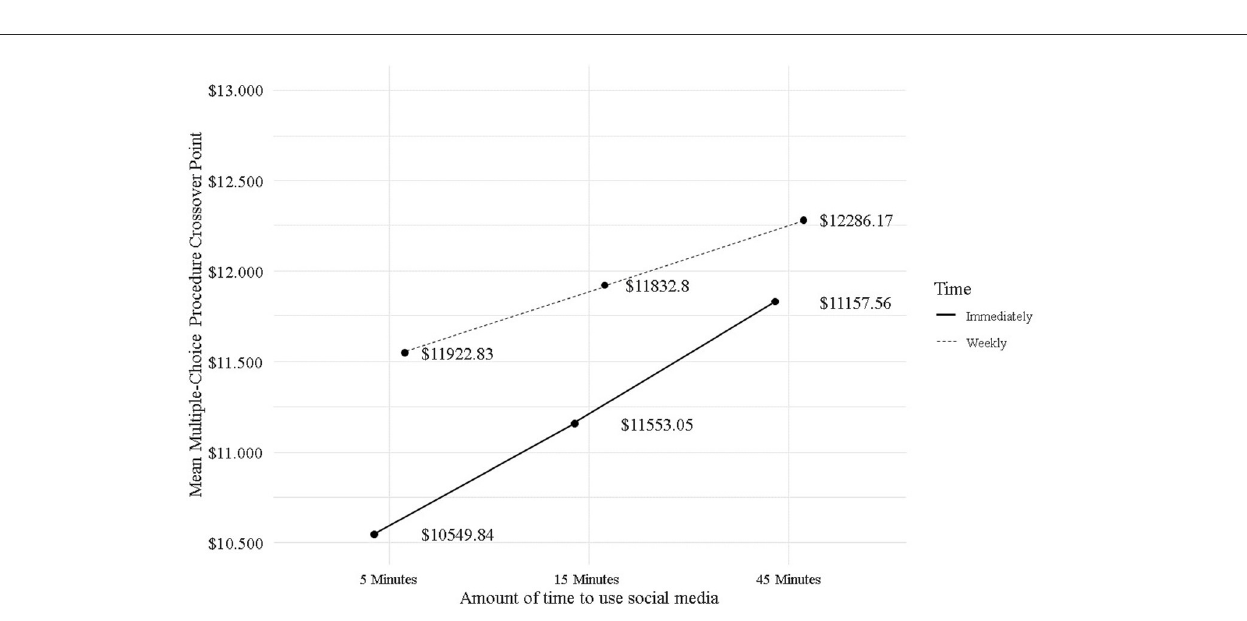
FIGURE1 Mean Multiple Choice Procedure crossover points of each of the six versions.